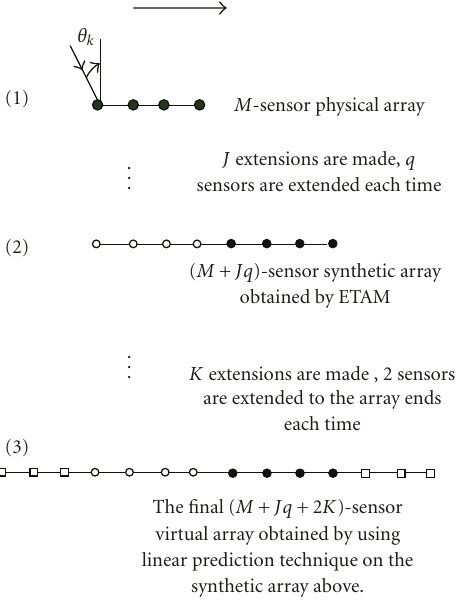
Figure 2: The array aperture extension